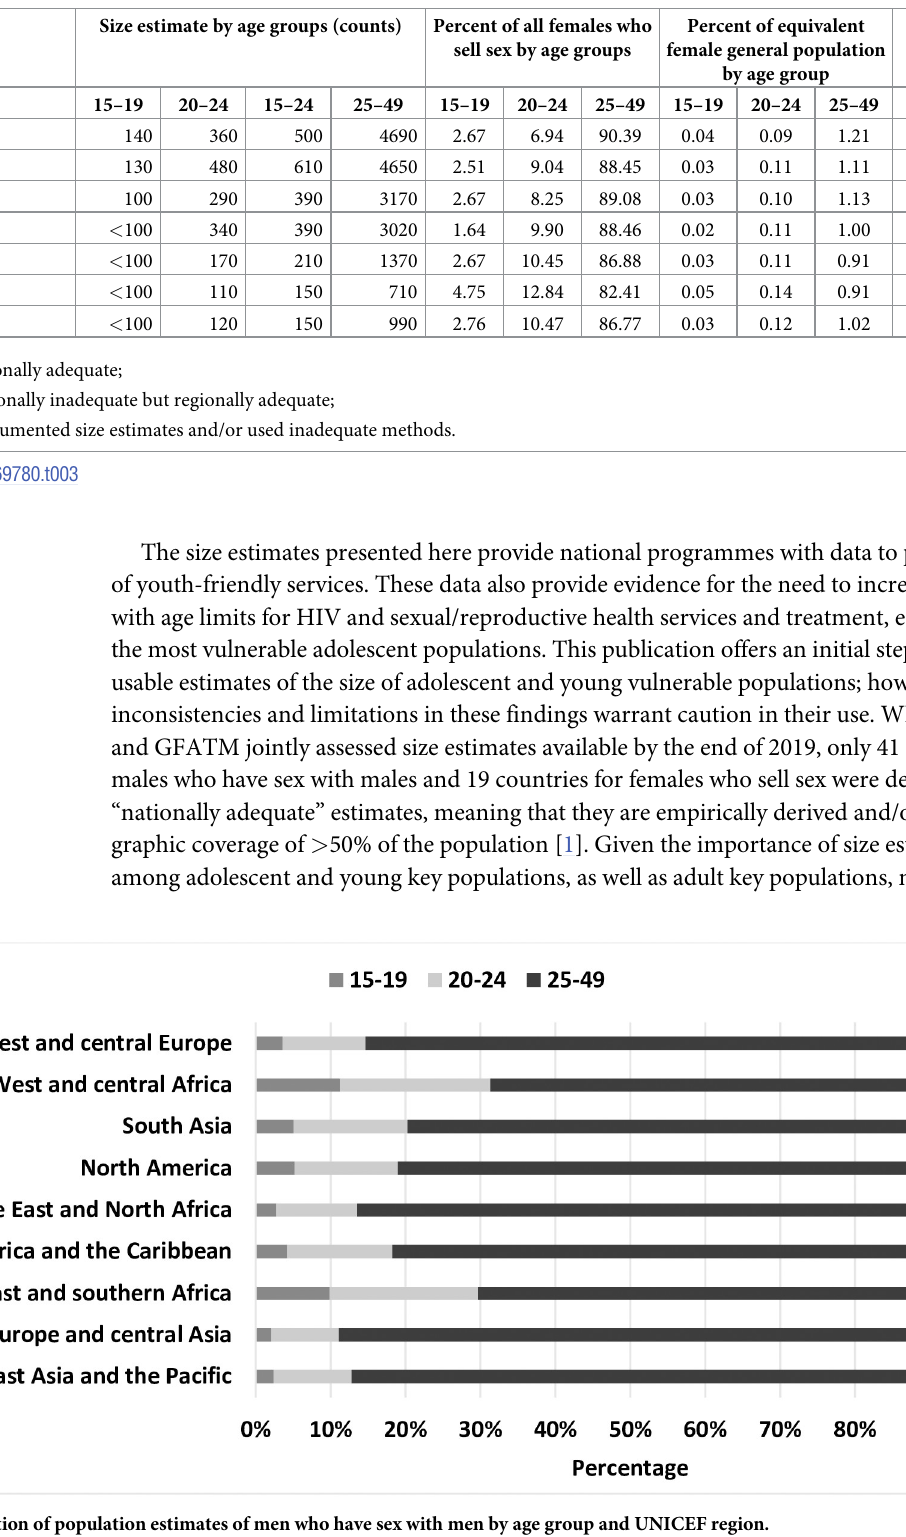
Fig 1. Distribution of population estimates of men who have sex with men by age group and UNICEF